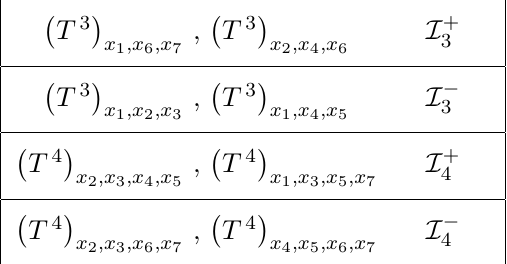
Table 4 . The tori whose image in the orbifold quotient give rise to the calibrated cycles corre- sponding to the T -dualities of equations